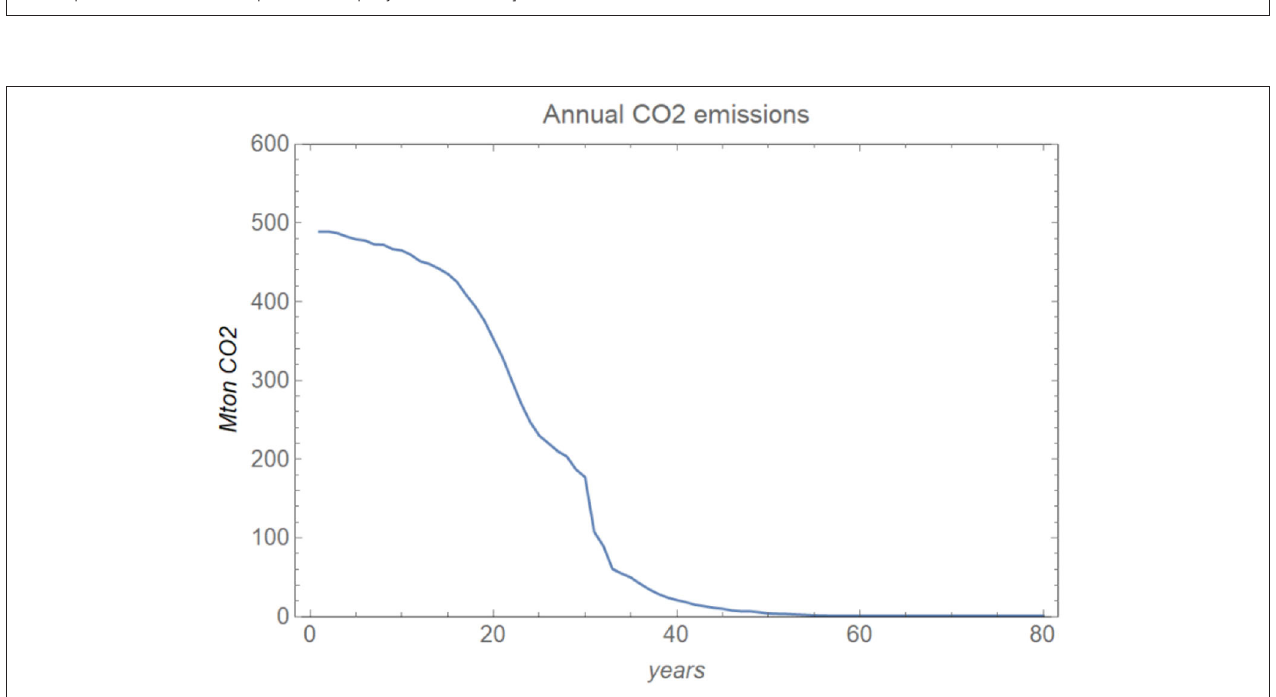
FIGURE 2 | Emissions in the base case [ f = 30% and i = 400M e . f is the fraction of an investment financed by a company’s own capital and i is the initial capital in a company’s bank account].